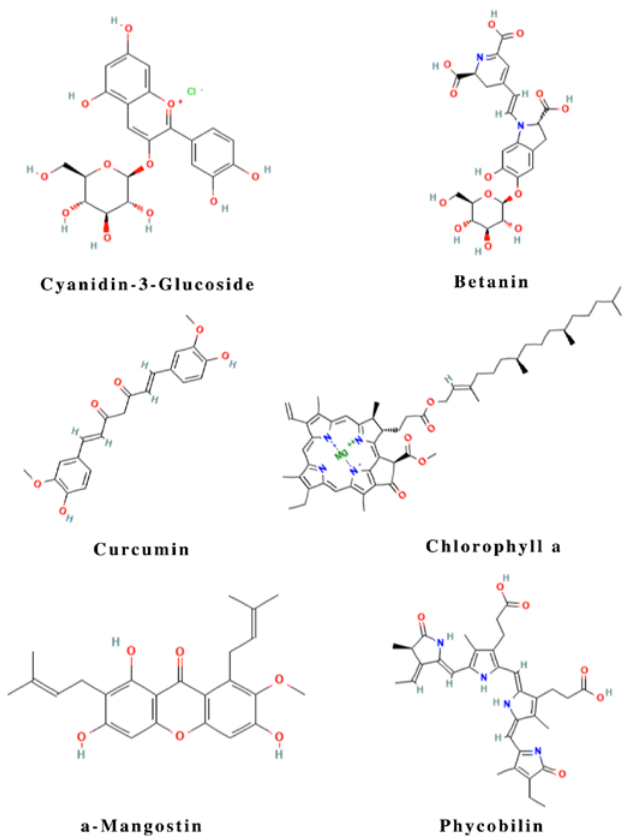
Figure 3. Structures of the major chemical species indicated in Table 1 [30–35]. Note the presence of appropriate oxygen-containing functional groups for anode binding, also shown in Table